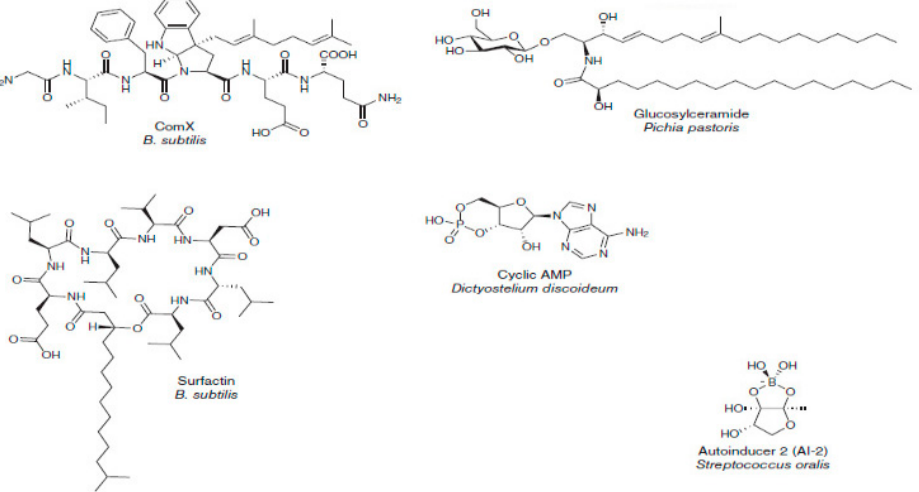
Figure 13. Examples of high-diversity molecules in the MDDR dataset.